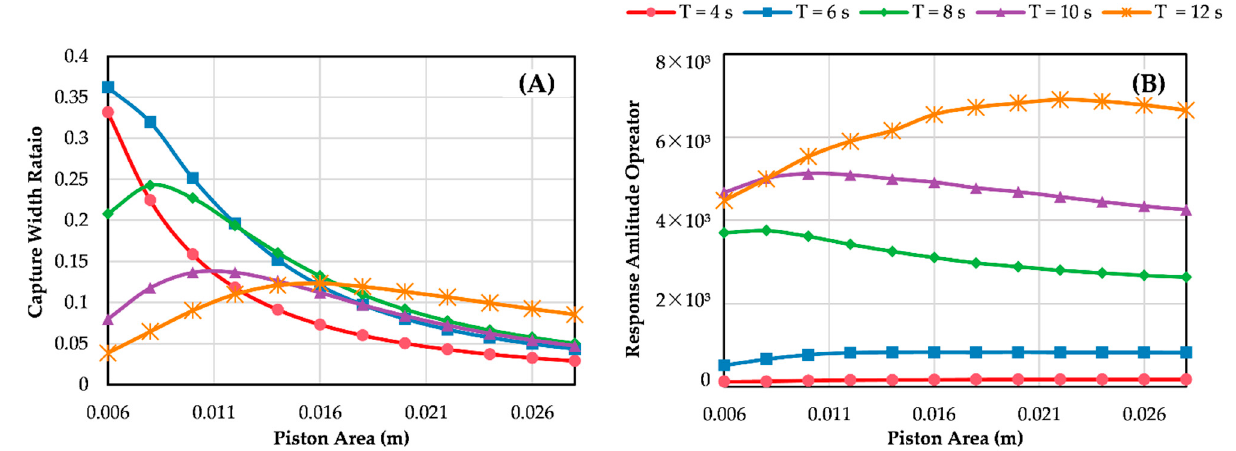
Figure 7. Influence of piston area on the performance of the hybrid system under wave height of 1.5 m. ( A ) Variation of CWR. ( B ) Variation of pitch motion RAO.